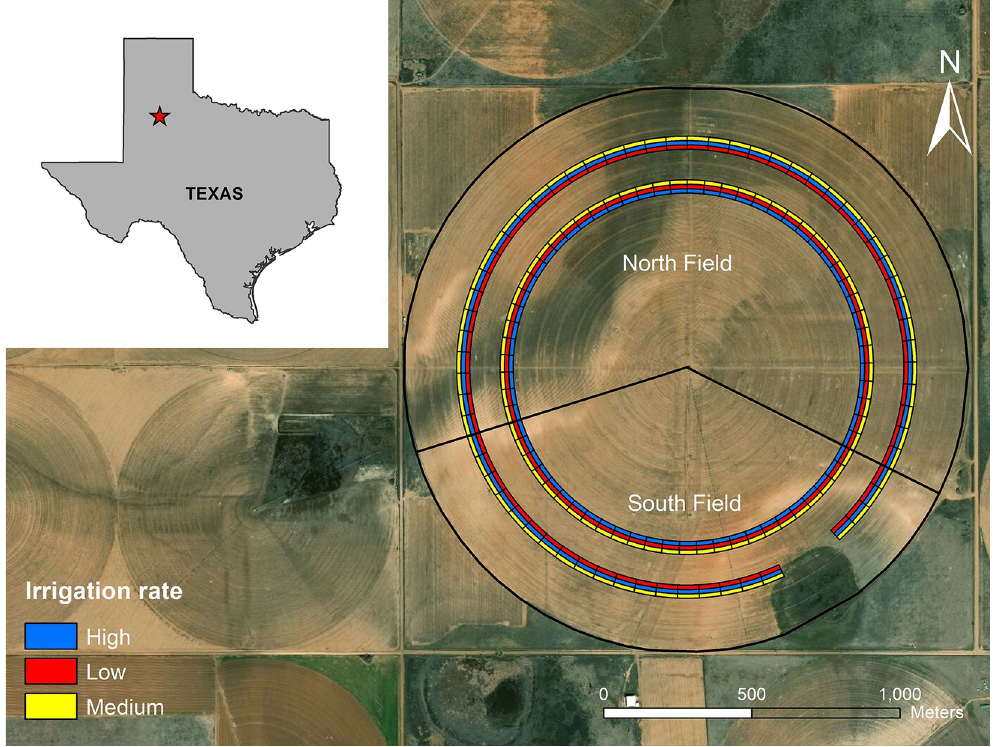
Fig 1. Study site with irrigation treatment design in two fields of a 194-ha farm in Hale County, Texas in 2017 (basemap source: Esri, DigitalGlobe, GeoEye, i-cubed, USDA FSA, USGS, AEX, Getmapping, Aerogrid, IGN, IGP, swisstopo, and the GIS User